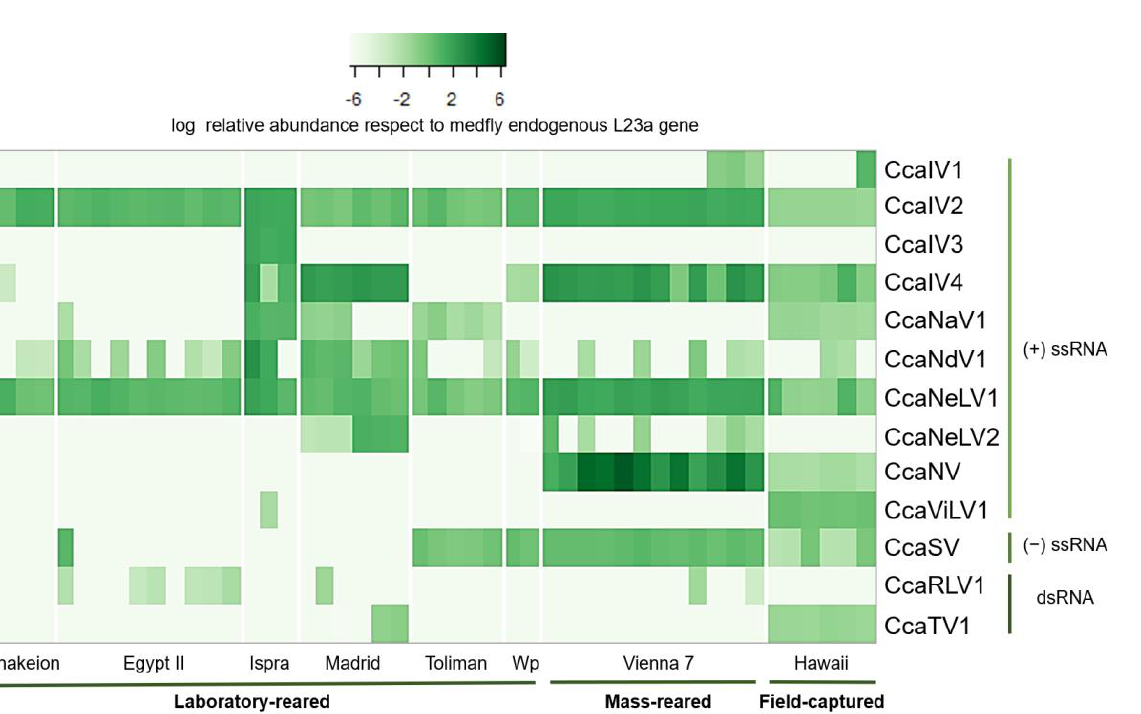
Figure 3. Viral relative abundance in sequence read archive (SRA) datasets. Heatmap of the relative abundance of the 13 medfly RNA viruses in 48 transcriptome datasets from eight different BioProjects available from NCBI. Color plot represents values of viral relative abundance calculated using the total viral counts and L23a mitochondrial gene counts, both determined by read mapping.